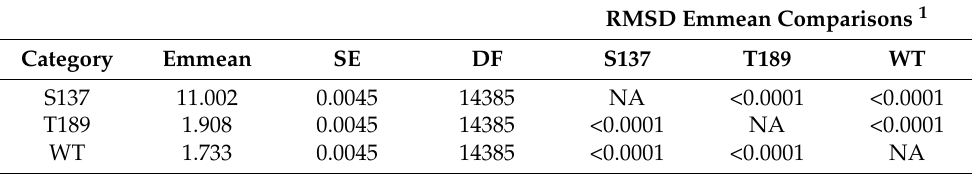
Figure 4. Principal component analysis (PCA) of the cartesian coordinates through the simulation for the three simulated NS3 structures. ( A ) Principal component 1 vs. principal component 2 of three simulated NS3 “all” amino acid residues throughout the MD simulation compared to the starting structure (unphosphorylated WT at time 0 ns). The WT is shown in “black,” S137 is in “light blue,” and T189 is in “red.” ( B ) Principal component 1 vs. principal component 2 of three simulated NS3 amino acid residues (49–94) throughout the MD simulation compared to the starting structure (unphosphorylated WT at time 0 ns). The WT is shown in “black,” S137 is in “light blue,” and T189 is in “red.” ( C ) Principal component 1 vs. principal component 2 of three simulated NS3 amino acid residues (566–585) throughout the MD simulation compared to the starting structure (unphosphorylated WT at time 0 ns). The WT is shown in “black,” S137 is in “light blue,” and T189 is in “red.” Table 5. Estimated marginal means (emmean) pairwise comparisons of the simulated structures RMSD (residues